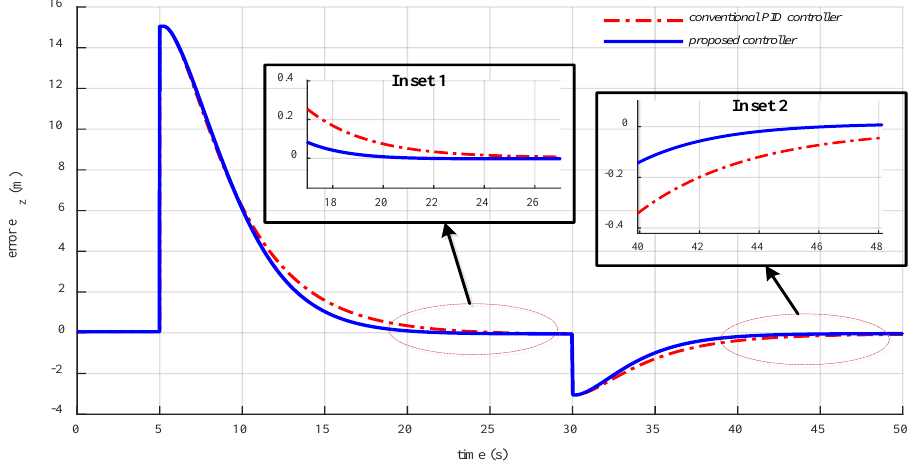
Figure 8. Comparison of altitude tracking error convergence between our new controller and a conventional PID controller for Scenario 1.